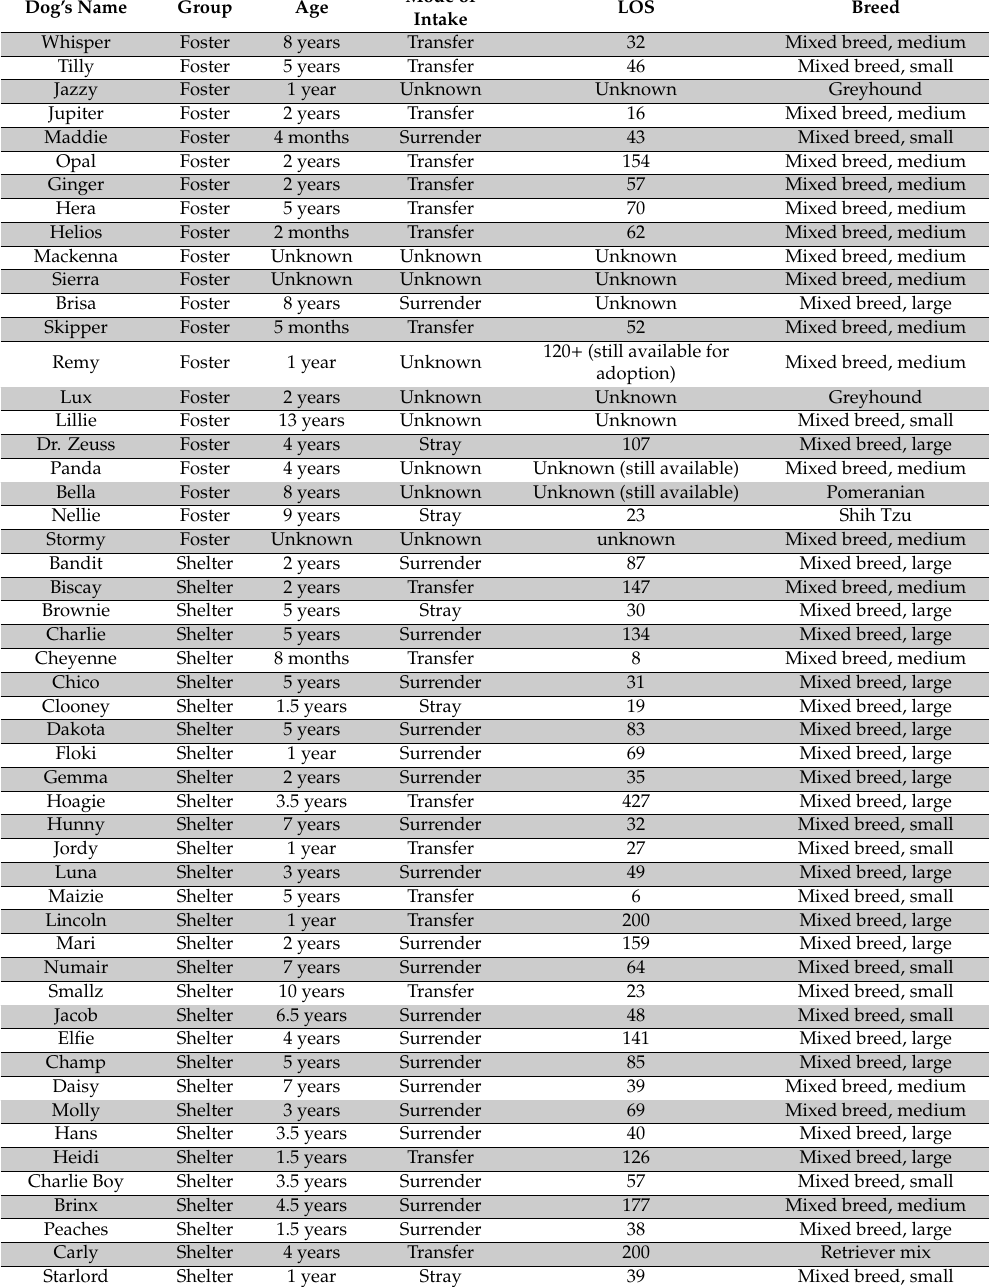
Table A1. Subjects’ demographic information, including names, groups, ages, modes of intake, length of stay (LOS), and breed (as listed by their associated shelter or rescue group). Several of the dogs in the study were returned; length of stay was calculated based on initial intake date and final adoption date. All dogs were spayed and neutered prior to participating in the study. Length of stay data were not available for some dogs that participated, and in a few cases (noted below), dogs were still available for adoption at the completion of the study. All breed determinations were based on visual inspection by the participating shelters and rescue groups, and it is important to note that reliability for this method is low